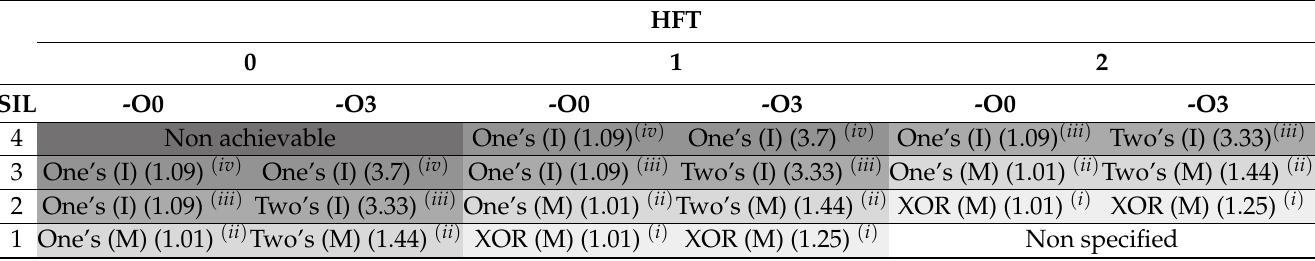
Table 4. Selected checksums for 80 × 80 matrix dimension according to SIL and HFT.